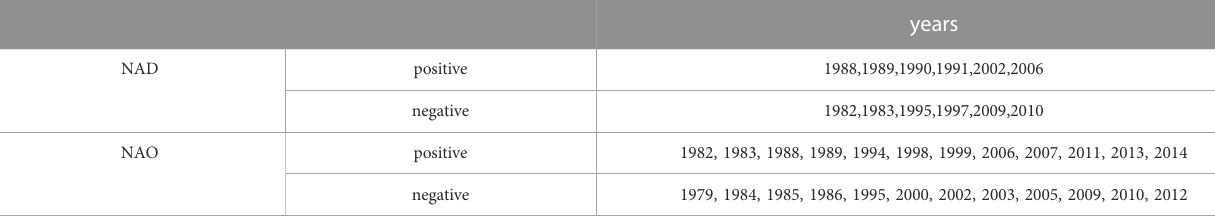
TABLE 1 Classi fi cation of years in which positive (negative) NAD and NAO